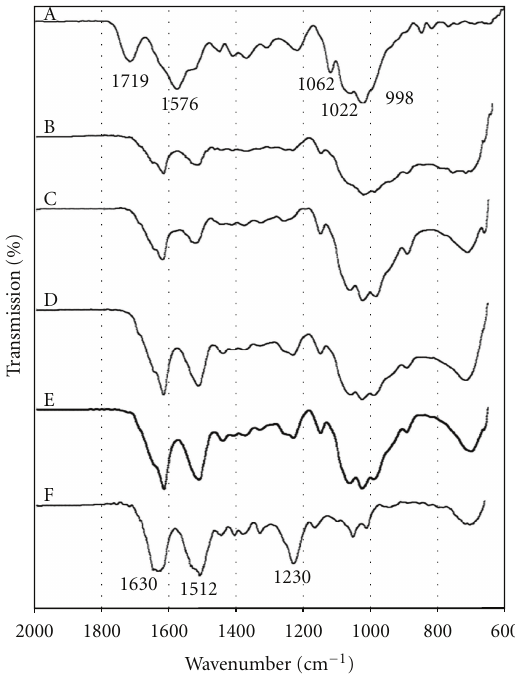
Figure 2: FTIR spectra of (A) CS film and CS/SF blend films with various blend ratios of chitosan :fibroin (CF) of (B) 3 :1, (C) 2:1, (D) 1 :1, (E) 1:2 and (F) SF